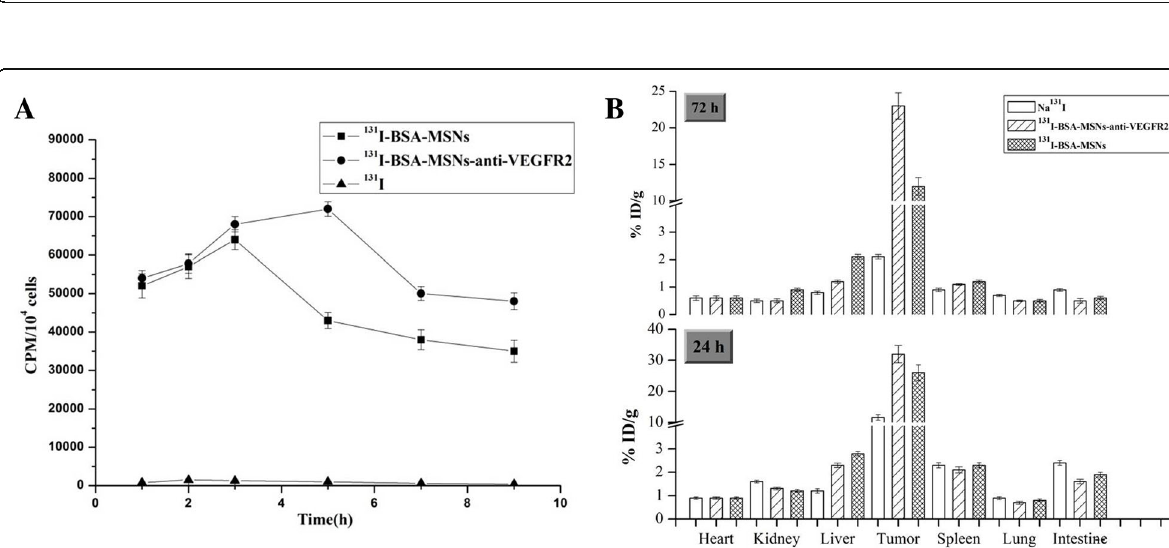
Fig. 3 Time-dependent cellular uptake and tissue distribution. a The data on time-dependent cellular uptake are presented as the mean ± SD of three groups. b Comparison of the data on the biodistribution of 131 I in the tumor and major organs of ATC tumor-bearing mice at 24 and 72 h after intratumoral injection of Na 131 I, 131 I-BSA-MSNs, and 131 I-BSA-MSNs-anti-VEGFR2. The tumor tissue radioactivity of anti-VEGFR2 targeted group at 24 and 72 h after intratumoral injection (32.2 ± 2.8% ID/g and 23.0 ± 1.8% ID/g, respectively) was significantly higher than that of non-targeted group (26.1 ± 2.5% ID/g and 12.3 ± 1.2% ID/g, respectively) (all P < 0.05). Data are also presented as the mean ± SD for the three